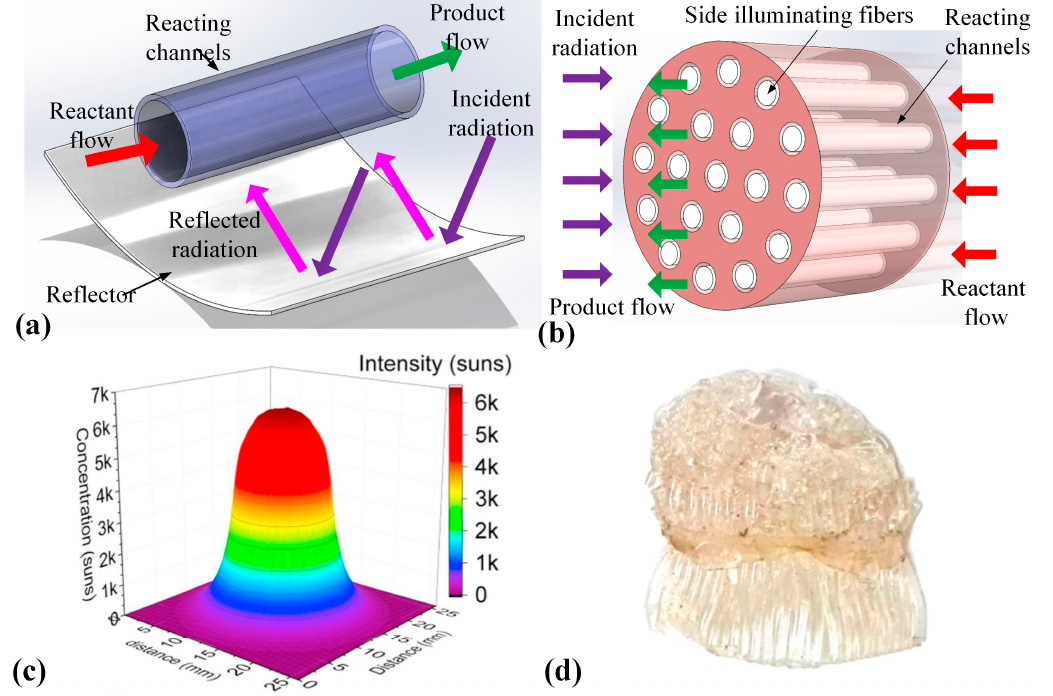
Figure 1. Schematics of ( a ) the continuous reactor coupled with a reflector and ( b ) the OFMR, ( c ) the map of concentrated irradiative flux, and ( d ) the melted optical fibers in the point concentrating system (reprinted from Ref [33]).